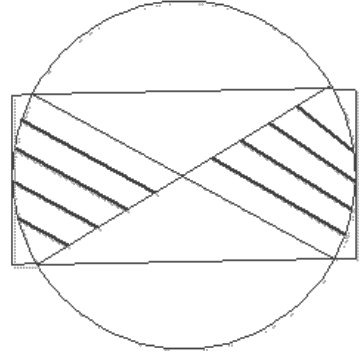
Figure 7. Sensor node charge signal strength.